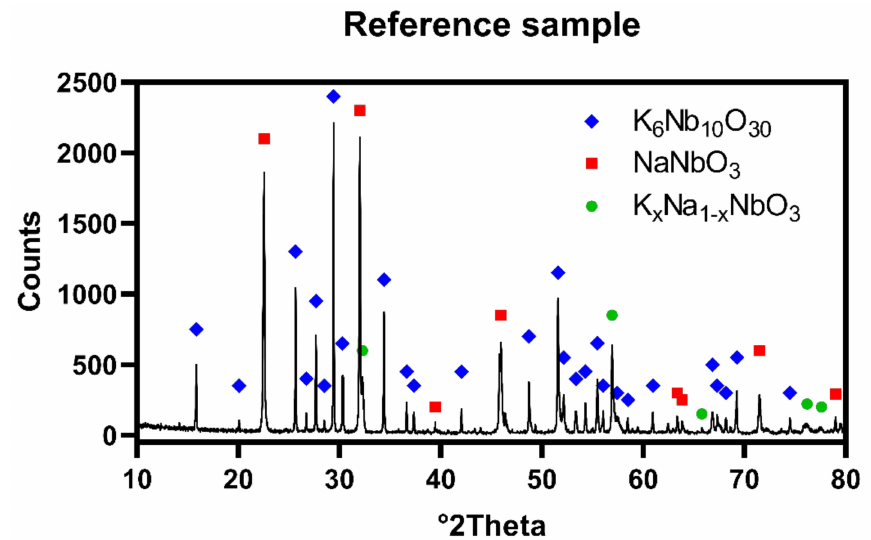
Figure 2. X-ray di ff raction (XRD) pattern of reference sample hot-pressed without sintering additions, under 25 MPa of pressure for 2 h at 1100 ◦ C in argon flow with heating / cooling rate of 10 ◦ C / min and 8 ◦ C / min, respectively.